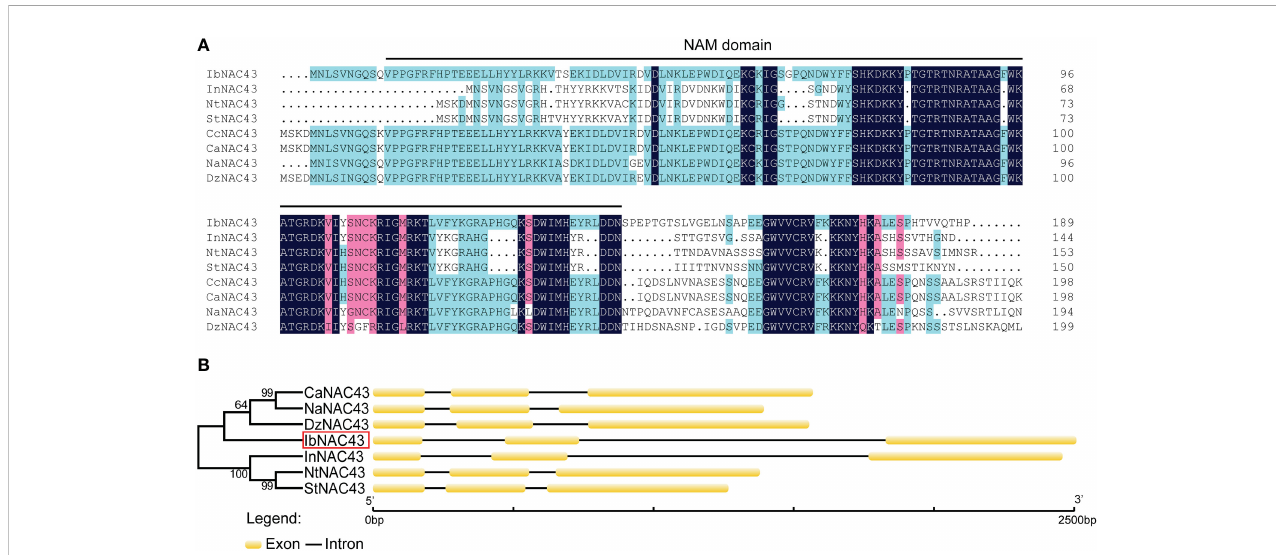
FIGURE 1 Sequence analysis of IbNAC43. (A) Multiple sequence alignment of the bNAC43 protein and its closest homologs from different plant species. The NAM (no apical meristem) domain is represented by black lines . (B) Phylogenetic relationships and genomic structures of IbNAC43 and its closest homologs from different plant species. The IbNAC43 cloned in this study is indicated by a red box . Exons are represented by boxes , while introns are represented by lines